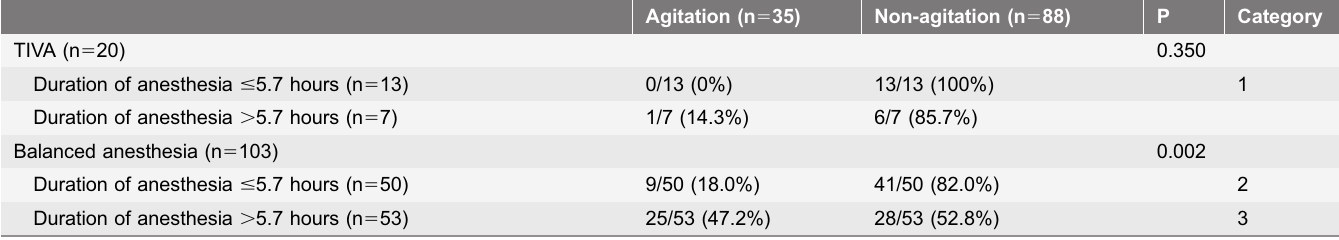
Table 3. Interaction between duration and method of anesthesia.